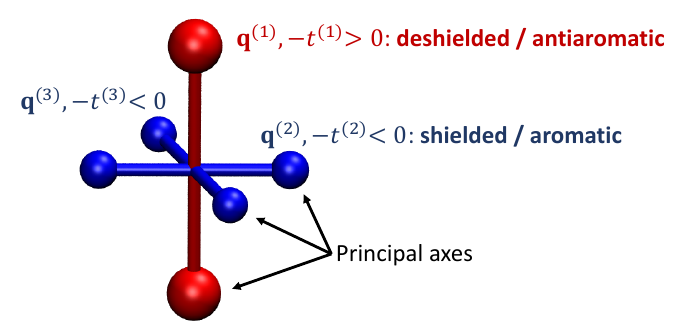
Figure 1. Visualisation of the chemical shielding tensor (VIST) via its three principal axes q ( 1 ) , q ( 2 ) , q ( 3 ) and the associated eigenvalues t ( 1 ) , t ( 2 ) , t ( 3 ) .